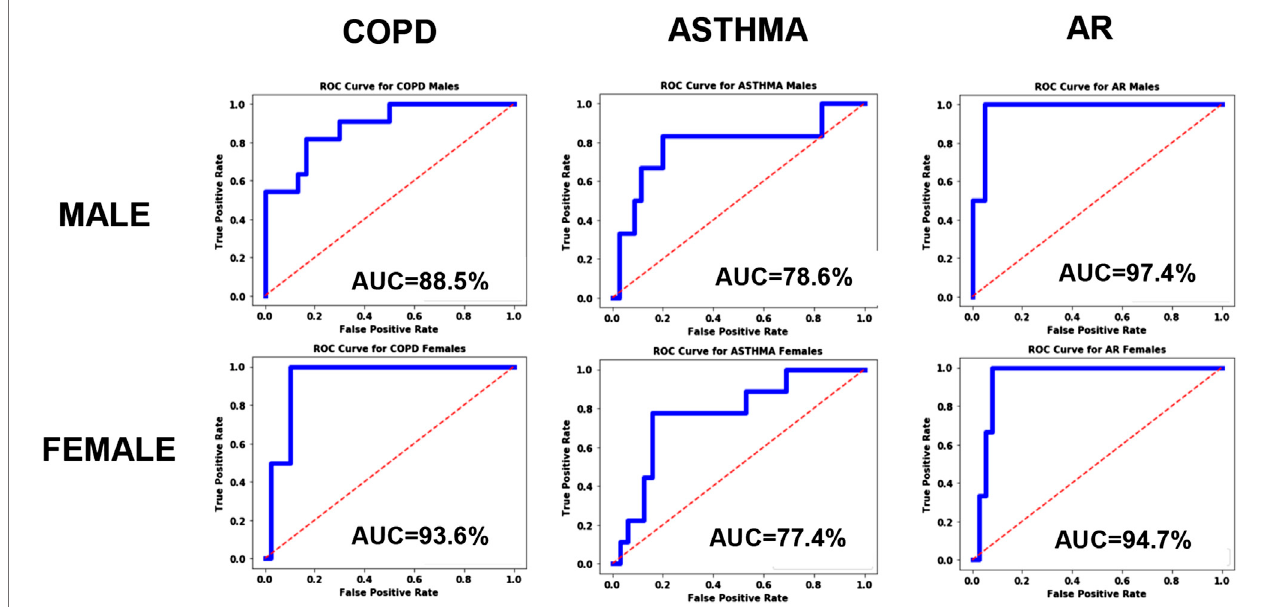
FIGURE 4 | ROC curves for the disease models corresponding to COPD, Asthma and AR as a function of Gender.